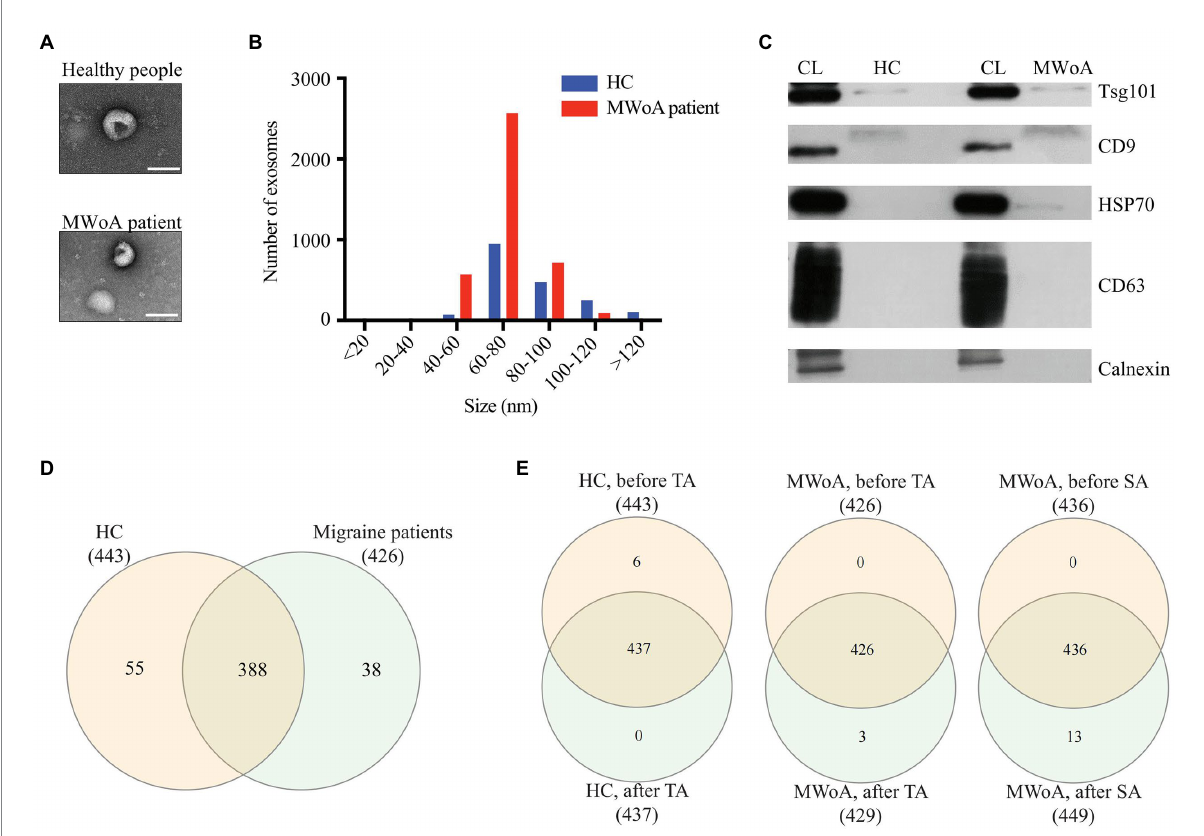
FIGURE 2 Characterization of exosomes and miRNAs identified in HC, trAMWoA and shAMWoA before and after treatment. (A) TEM results of exosomes from MWoA patients and HC. (B) The mean size of exosomes of MWoA patients and HC participants by NTA. (C) WB revealed CD9 and TSG101 proteins in exosome samples. (D) miRNAs identified in HC and MWoA patients. (E) miRNAs identified in HC, trAMWoA and shAMWoA before and after 4-week treatment. MWoA, migraine without aura patients; HC, healthy control; TA, true acupuncture; SA, sham